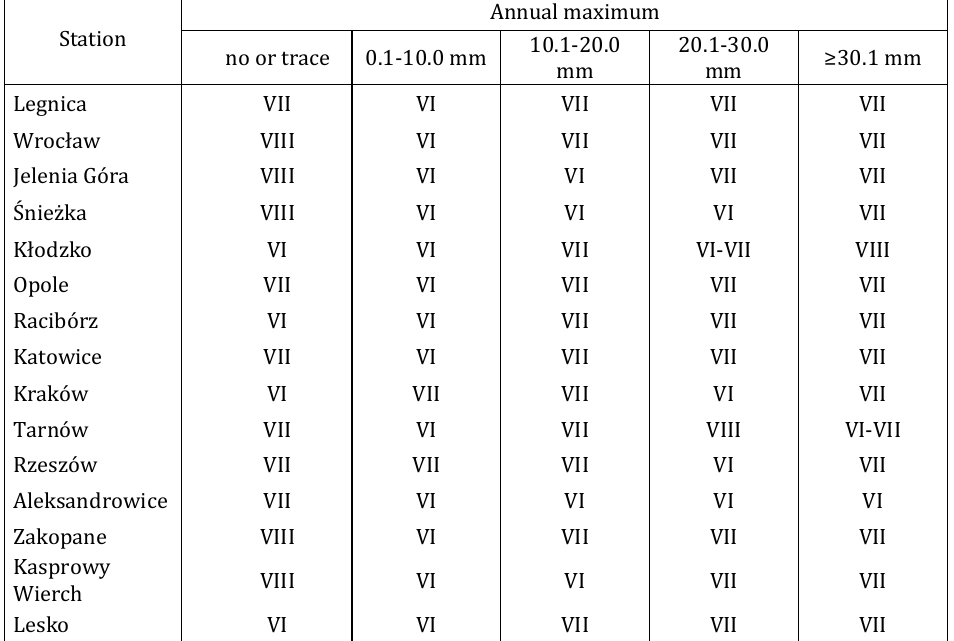
Table 4. Annual maximum of certain daily sums of precipitation occurrence on the days with thunderstorm in the period